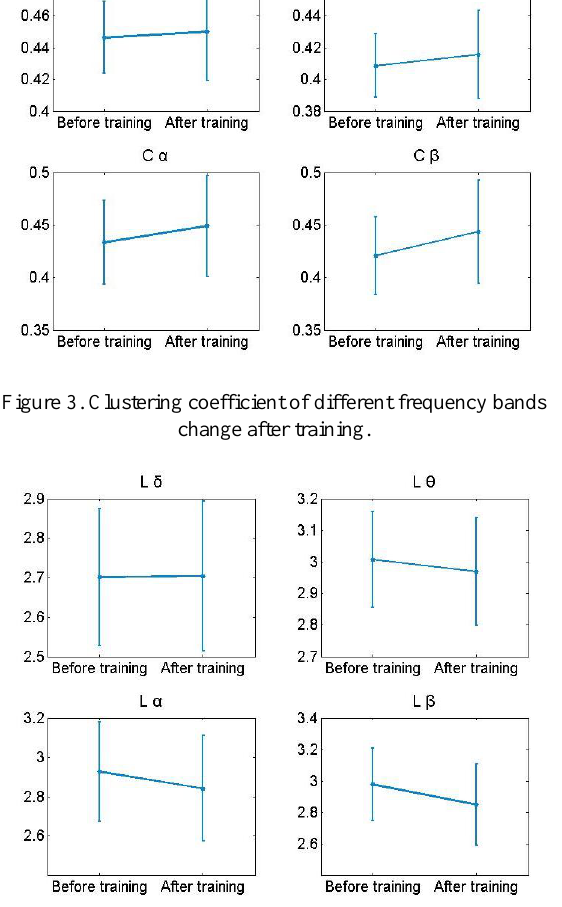
Figure 4. Average shortest path length of different frequency bands change after